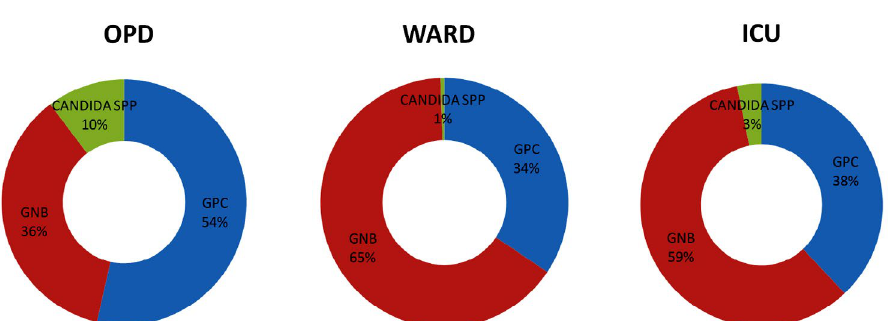
Fig. 2. Percentage distribution of Gram-positive cocci, Gram-negative bacilli and Candida spp isolates among samples from OPD, Ward and